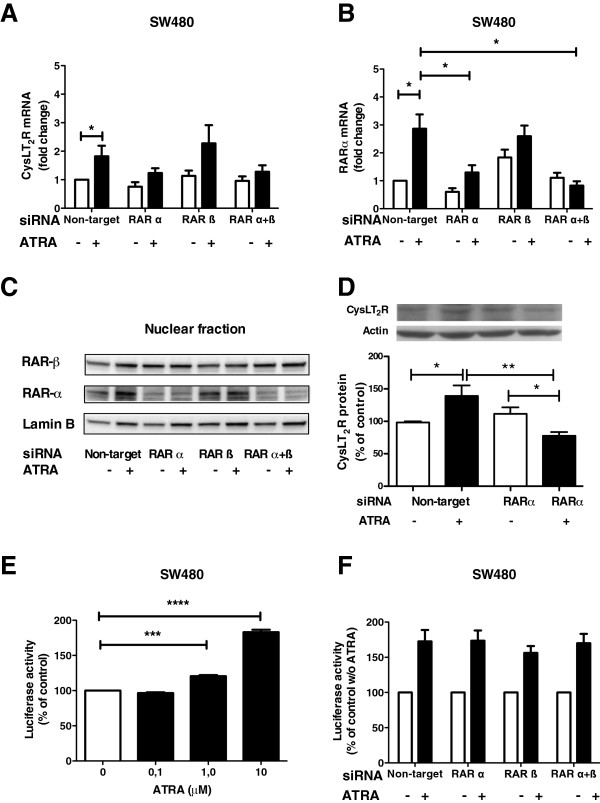
All transfected cells (ExGen1, 2,3 and Elec1, 2) added substrate 5 μl of coelenterazine (50 μg/ml), Output (p/sec/cm2/sr) was recorded using IVIS machine with in 10 second of the substrate addition.